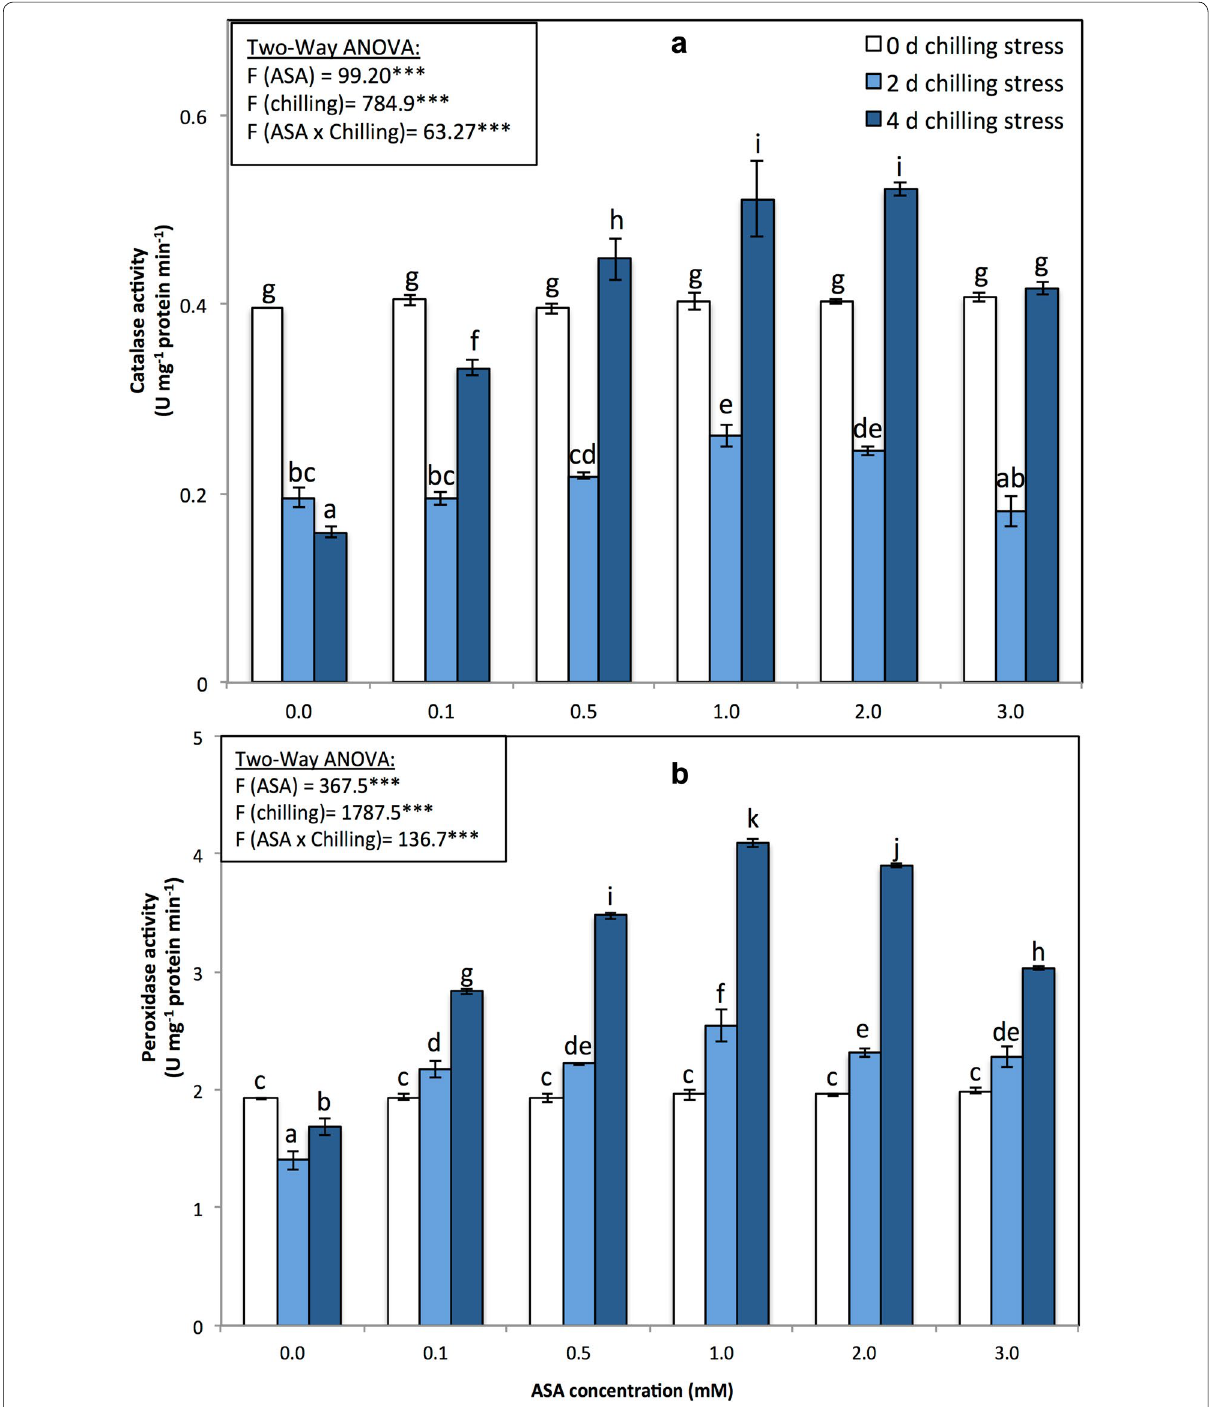
Fig. 5 a Catalase (unit mg − 1 protein min − 1 ) and b peroxidase activities (unit mg − 1 protein min − 1 ) of P. vulgaris L. after foliar application of different concentration of acetylsalicylic acid (ASA; 0, 0.1, 0.5, 1, 2, 3 mM) and exposed to different level of chilling stress (0, 2, 4 days). Data represented are mean of two replicates standard deviation. Variations between different chilling stresses and foliar ASA concentration were assessed by univariate ± analyses followed by post hoc analysis. Means with the same letters are not significantly different according to Duncan’s multiple